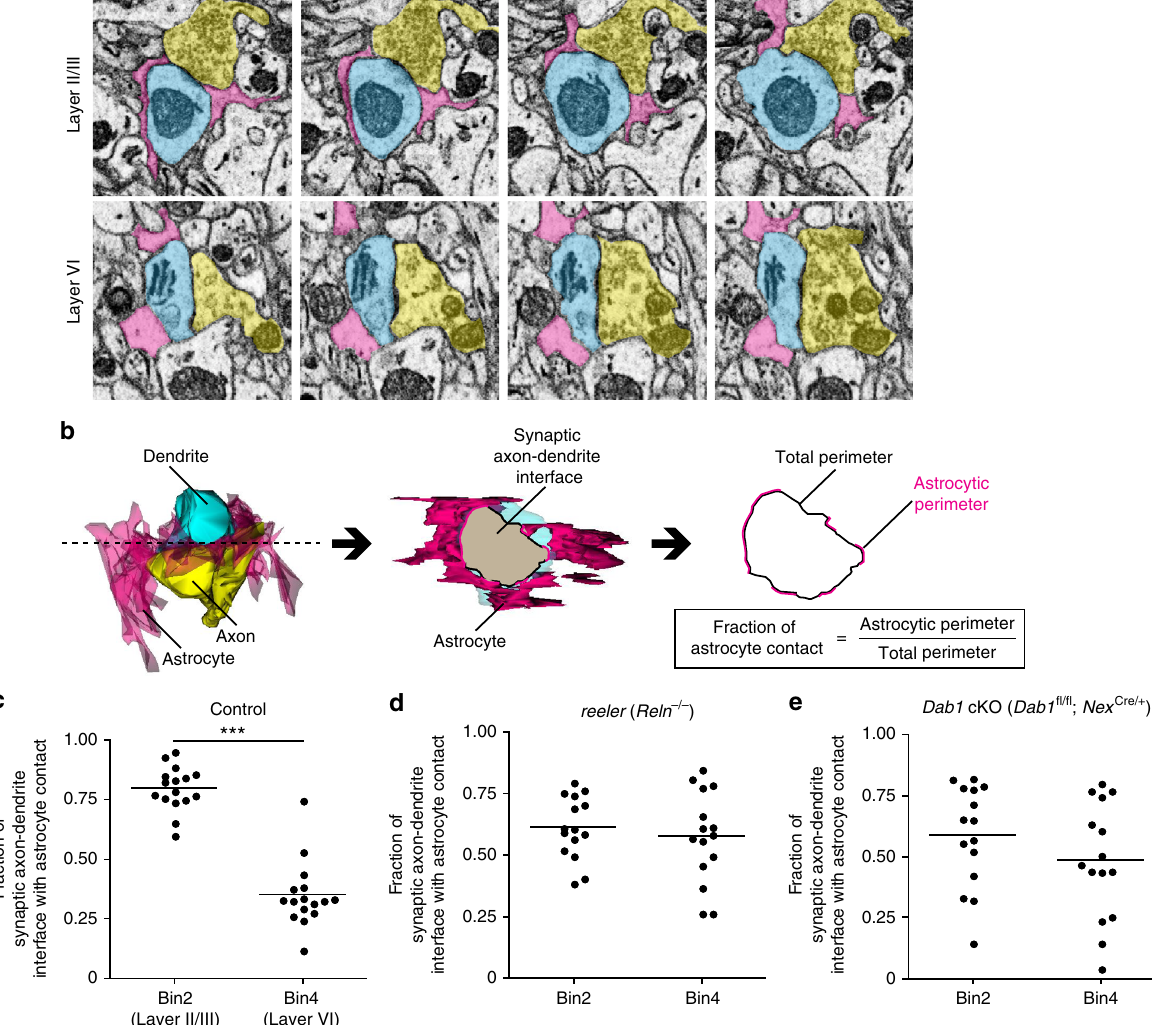
Fig. 3 Difference in astrocyte-synapse structural interactions in layers II/III and VI. a Series of SBF-SEM images acquired from coronal sections of the brain of an adult wild-type mouse at ×4730 magni fi cation. b Procedure for quanti fi cation of astrocyte ensheathment of synapses. Serial SEM images were reconstructed to measure the perimeter of synaptic axon-dendrite interface and the astrocytic perimeter. c – e Quanti fi cation of astrocyte ensheathment of synapses in bin2 and bin4 ( n = 16 synapses in each bin for control ( c ) and n = 15 synapses in each bin for reeler ( d ) and Dab1 cKO ( e ) mice). Astrocyte position in the cortical layers is expressed as relative distance from the corpus callosum (CC) to the pia: bin2, 0.65 – 0.9; and bin4, 0 – 0.25. Horizontal bars represent mean values. *** P < 0.001 (Welch ’ s t